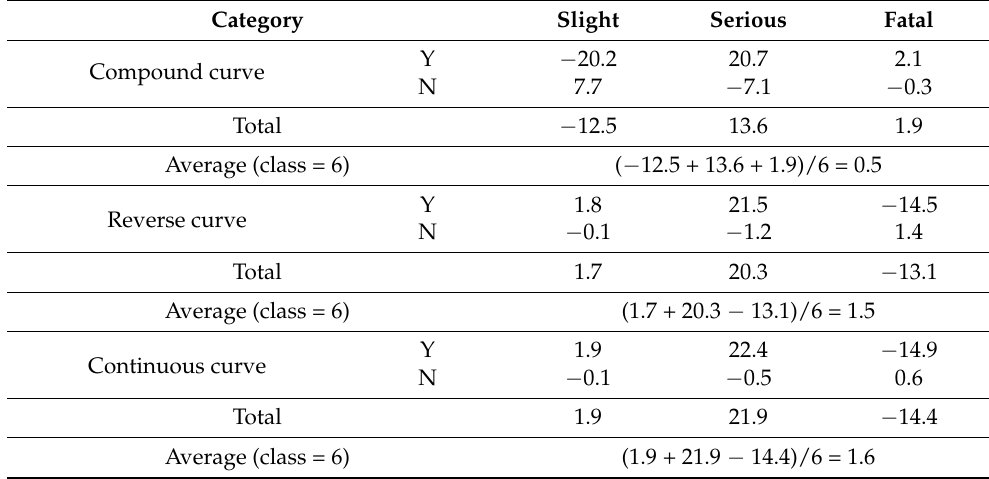
Table 6. Results of curve type of road variable threshold calculation.